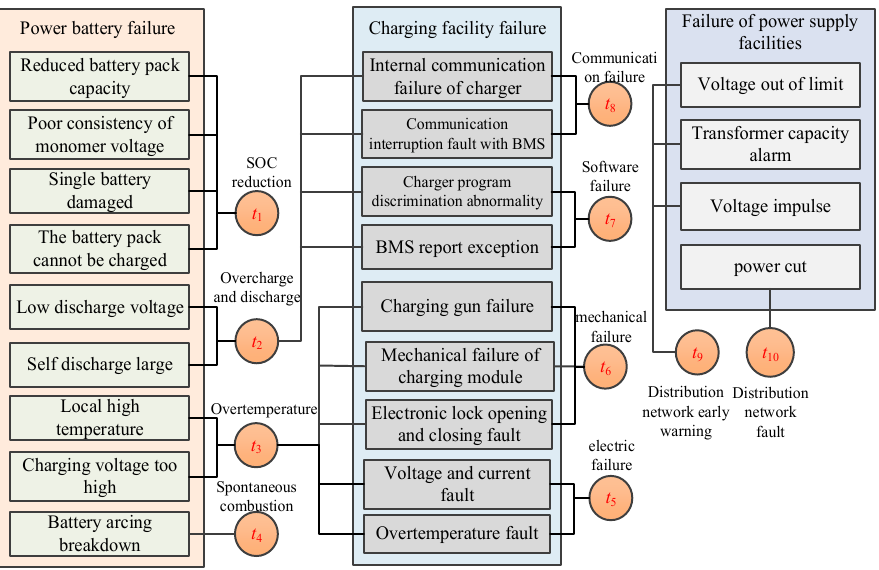
Figure 2. Information flow model of equipment fault correlation in the charging process.